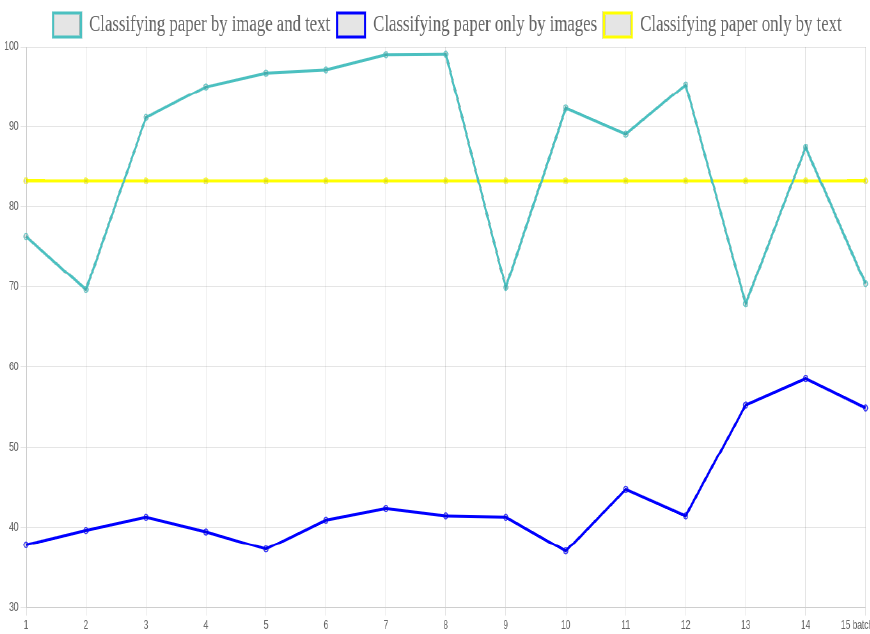
Figure 3. Trend of accuracy in different batch sizes.